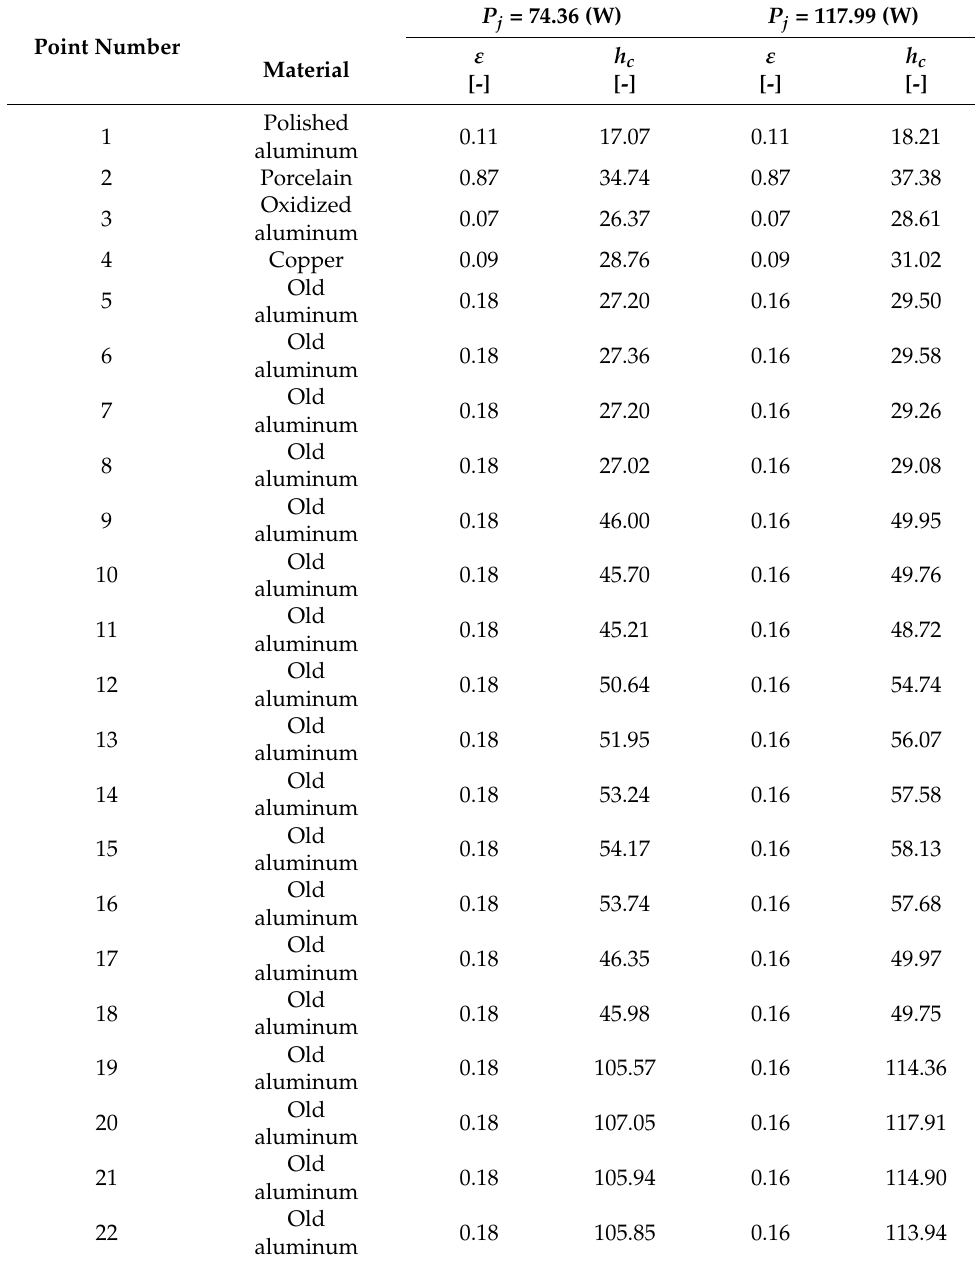
Table 3. The values of the ε and h c coefficients selected for each of the points presented in Figure 2 for P j = 74.36 W and P j = 117.99